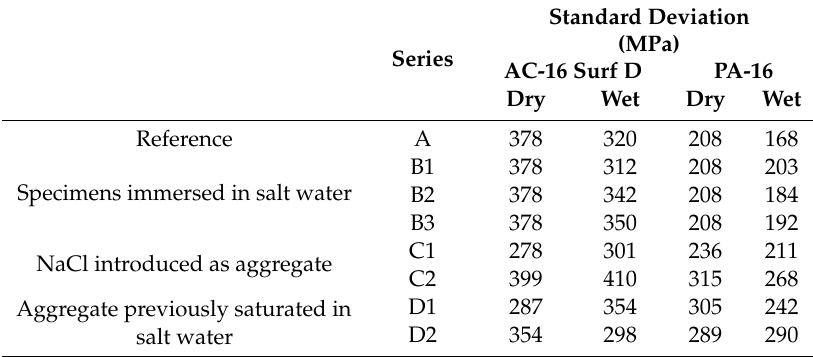
Table 2. Resilient modulus. Standard